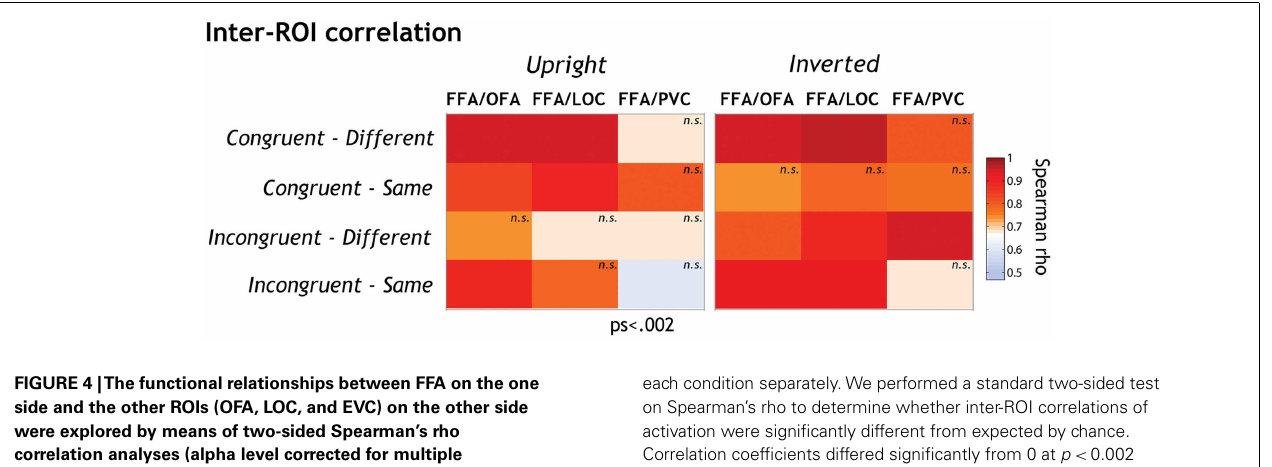
each condition separately.We performed a standard two-sided test on Spearman’s rho to determine whether inter-ROI correlations of activation were significantly different from expected by chance. Correlation coefficients differed significantly from 0 at p < 0.002 except when labeled